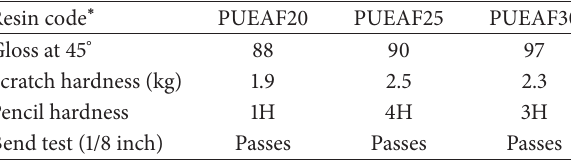
Table 1: Physicomechanical characterization of PUEAF coatings.